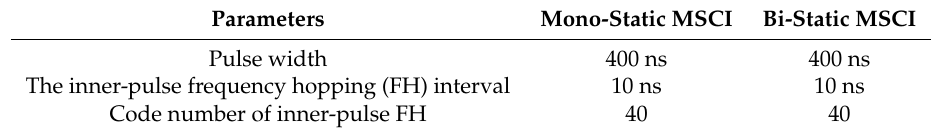
Table 2. Parameters of the inner-and-inter pulse frequency hopping (IAIP-FH) signal in this subsection.